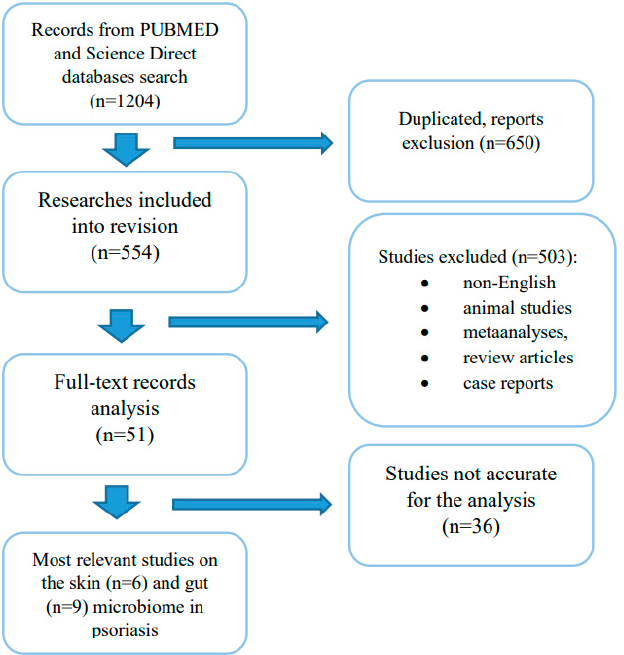
Figure 2. A graphical diagram of the selection of the literature data for the review.